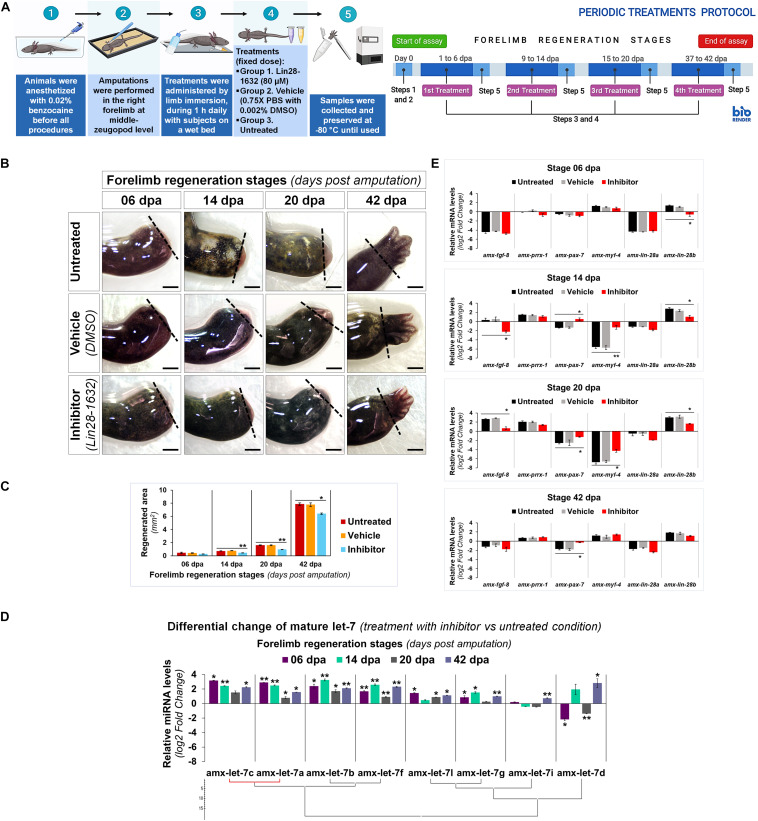
Characterization of induced effects after Lin28 inhibition in key regeneration stages. (A) Schematic diagram of the periodic administration protocol followed; on the left side, it shows the general strategy implemented, and on the right side, the temporary management schedule to each regeneration stage of interest. Created with BioRender. (B) Morphological changes observed after administration of different treatments in most representative stages of regeneration. Dotted lines indicate the amputation site. Scale bars: 1 mm. (C) Morphometric analysis of regenerated areas to conditions assayed. (D) Differential change in maturation patterns of the let-7 family in representative regeneration stages after treatments with inhibitor (vs respective stages untreated). Hierarchical clustering of Ward with Manhattan distance measurement, marking in red a positive Pearson correlation of P < 0.05. (E) Relative transcript abundances of some genetic markers during key stages of limb epimorphosis. Data in the graphs are represented as mean ± s.e.m. (n = 3); *, P < 0.05; **, P < 0.01; one-way ANOVA with post hoc Dunnett test vs untreated control condition.